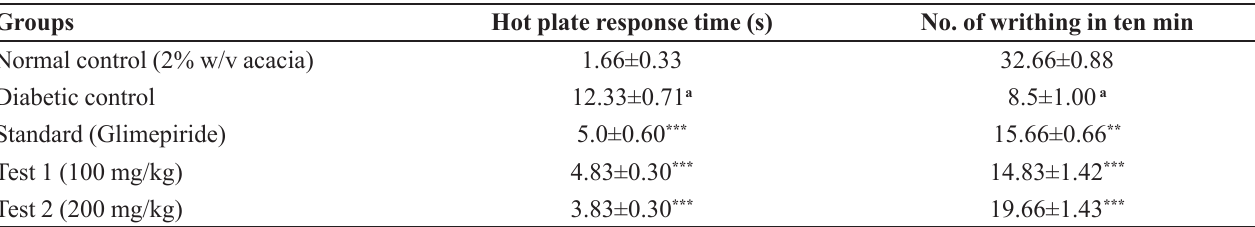
TABLE III - Effect of alcohol extract of W. volubilis root on diabetic neuropathy in Wistar rats